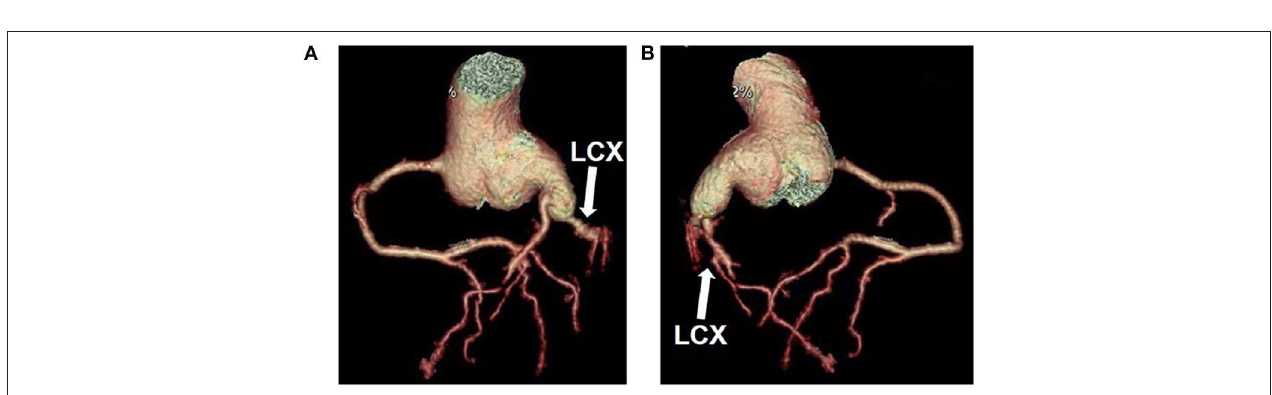
FIGURE 5 | The operation schematic diagram showed the distal aneurysm-like left circumflex artery was exposed within the right atrium (A) . The LCX fistula was shown by cutting the aneurysm (B) . CS, coronary sinus; SVC, superior vena cava; RIPV, right inferior pulmonary vein.